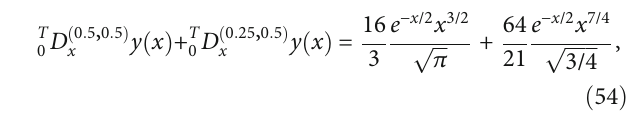
Figure 4: The comparison result of the approximate and exact solutions for Example 2 ( N = 6, 8 ). Table 3: Comparison of errors for proposed method with Jacobi- predictor-corrector algorithm [23] for Example 3 with α = 0 : 4 . N Max abs. error